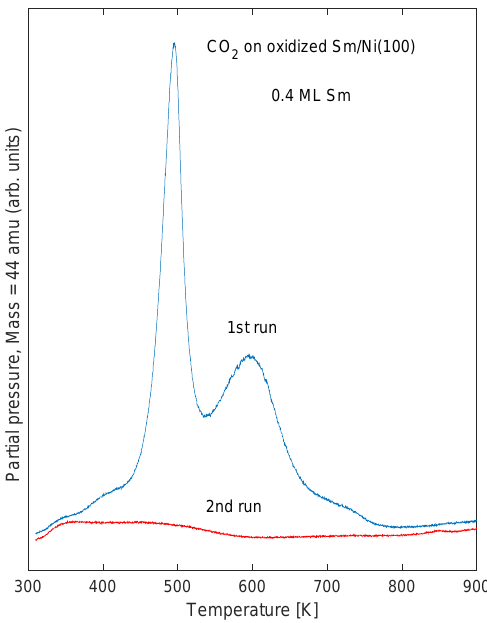
Figure 7. TPD spectra showing desorption of CO 2 before (1st run) and after (2nd run) cycling the sample temperature to 900 K, for an oxidized sample of effective Sm coverage 0.4